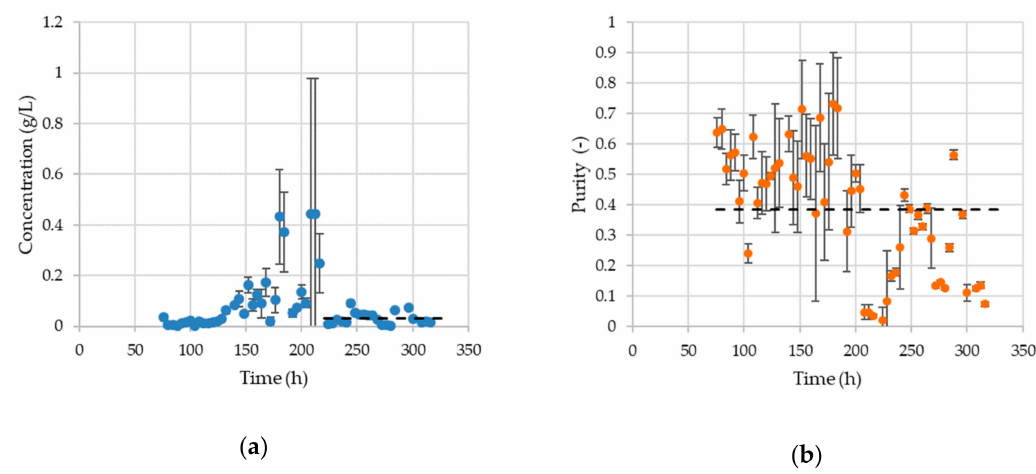
Figure 14. Development of ( a ) concentration and ( b ) purity for diafiltration steps. The dashed trendline depicts the stationary phase in terms of product concentration in ( a ) and the mean purity after diafiltration in ( b ). Error bars depict the double determination of each